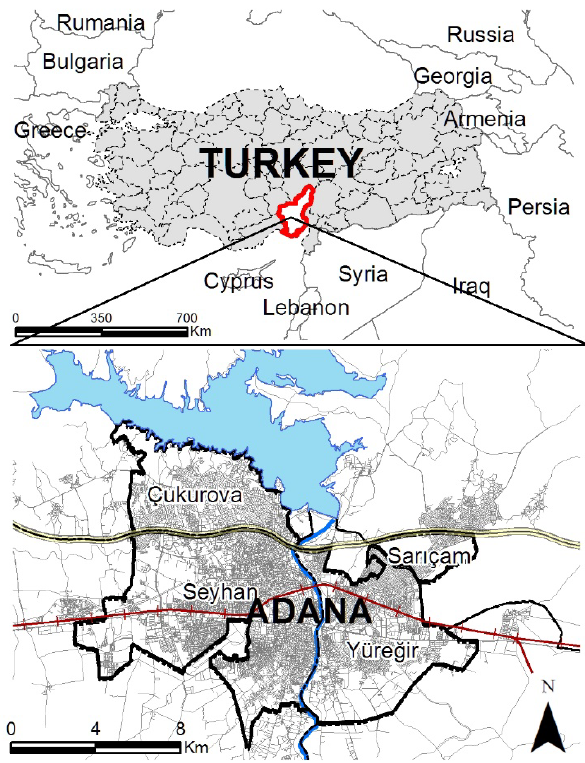
Figure 1. The study area of Adana, Turkey